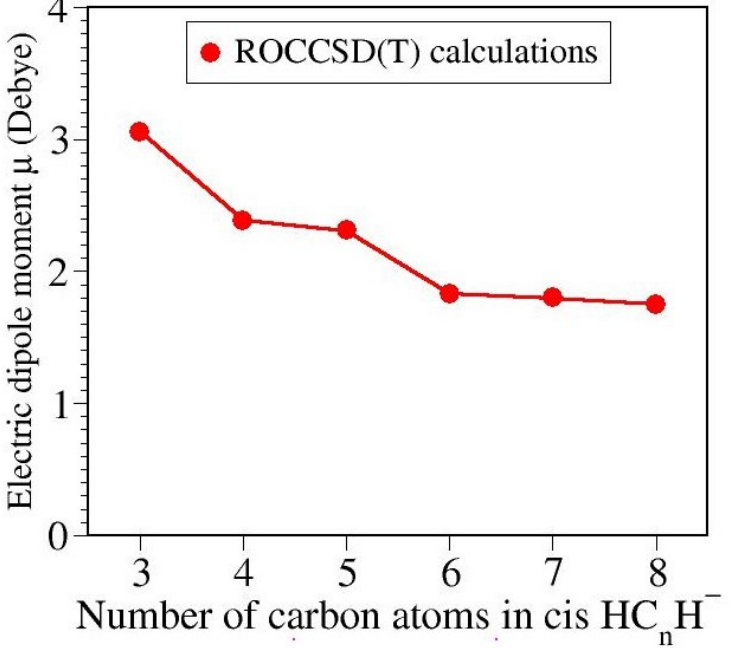
Figure 4. Cis HC n H – anions with n ≤ 8 possess reasonably large permanent dipole moments, and this can make them observable via rovibrational